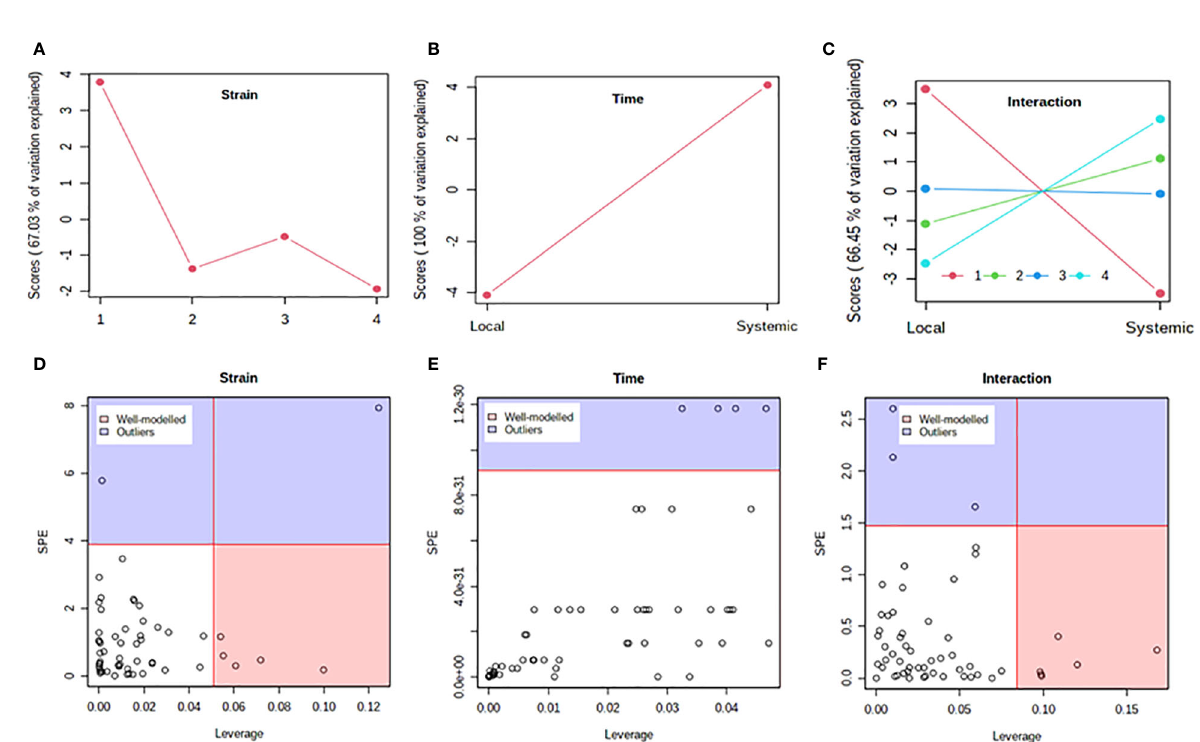
FIGURE 5 Analysis of variance – simultaneous component analysis (ASCA or ANOVA – SCA) of the differential host response to potato virus Y (PVY) infection of Russet Burbank. (A – C) : ASCA score plots showing the major patterns associated with strain, time, and their interaction; Plot legend for C: 1=mock, 2=PVY O , 3=PVY N-Wi , 4= PVY NTN . (D – F) : ASCA selection of important variables (metabolites) associated with strain, time, and their interaction by leverage/squared prediction error (SPE) analysis. Vertical and horizontal lines indicate cut-off leverage and SPE values, respectively. Metabolites with a high leverage value and a low SPE value were considered to be differential metabolites (the well-modeled group). Metabolites in blue have patterns that are different from the major patterns. The list of well-modeled metabolites is given in Supplementary Table S18.